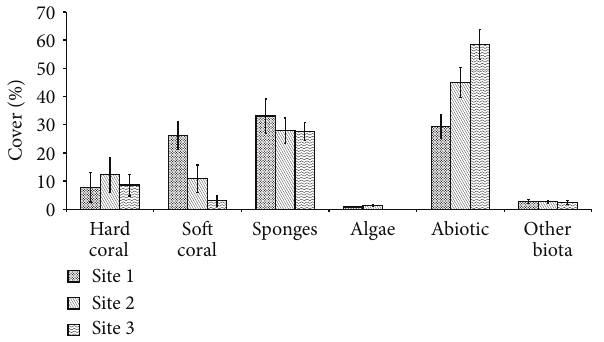
Figure 3: Average of coral cover in sampling sites at Hoga Island (mean ± SD, 𝑛 = 3